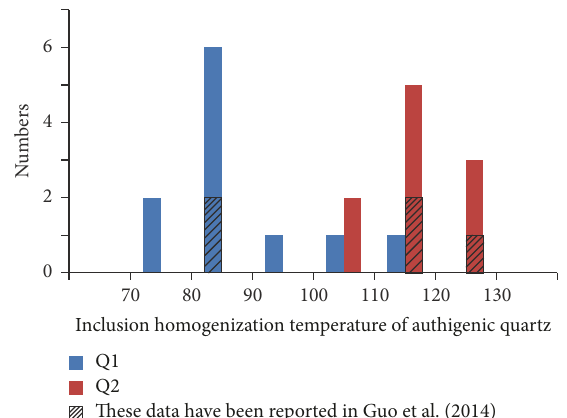
Q1 Q2 These data have been reported in Guo et al. Figure 12: The homogenization temperature of inclusion of authi- genic quartz with different morphological features in sandstones of Es, Dongying